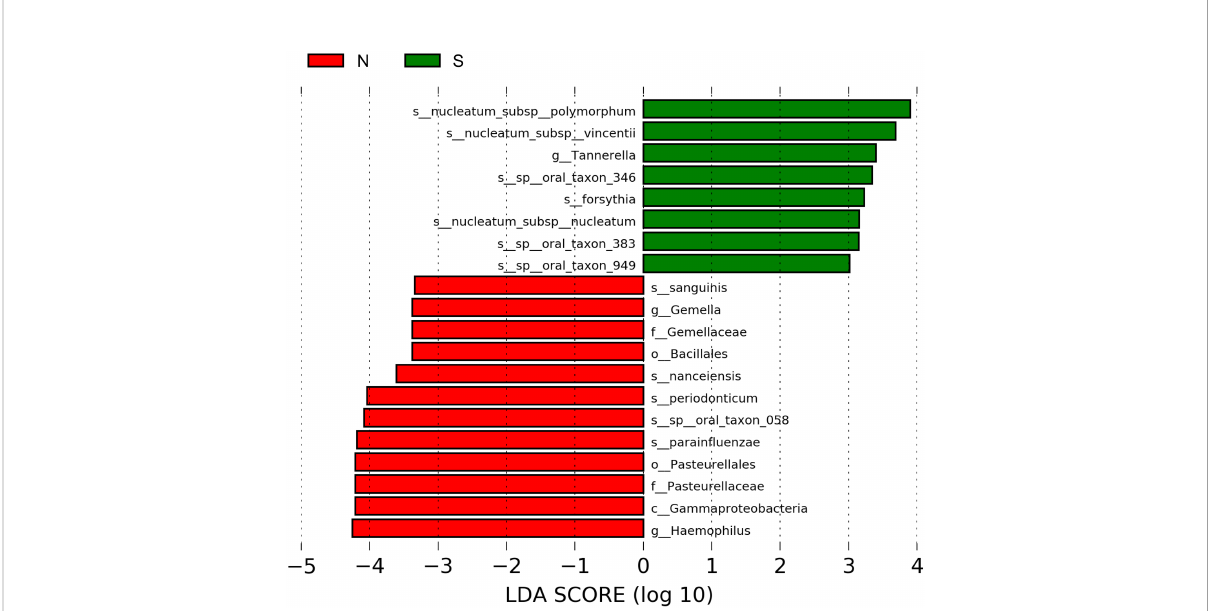
FIGURE 4 Graphics of linear discriminant analysis (LDA) effect size (LEfSe) for non-severe and severe groups. The horizontal bars indicate the effect size of each taxon. The length of the bar shows the log10 transformed LDA score, as indicated by the vertical dotted lines. The green and red bars indicate the non-severe and severe groups, respectively. The threshold of the logarithmic LDA score for the discriminative features was set to 3.0. The taxon of bacteria with a signi fi cant change (p <0.05) in relative abundance is shown along the horizontal lines. The taxon level is abbreviated as p, phylum; c, class; o, order; f, family; g, genus; and s, species; N, non-severe group; S, severe group.